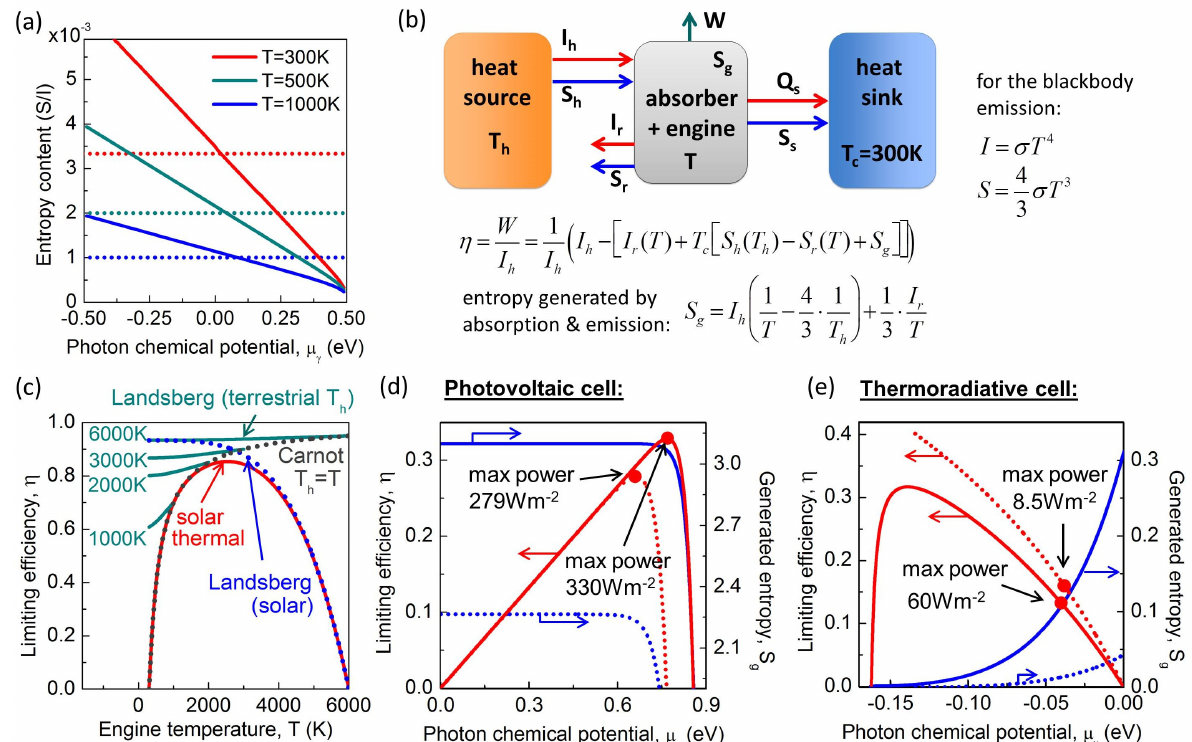
Fig. 2. Entropy of light and optical energy conversion limits. (a) The entropy content of light, defined as the ratio of the spectral entropy flux to the spectral power flux, as a function of the emitter chemical potential and temperature. The corresponding dotted lines for each temperature denote the entropy content for heat delivered at the same temperature via heat conduction (︀ S / I = T −1 )︀ . (b) Schematic of an energy-conversion device and a general expression for its conversion eflciency. (c) Eflciency limits for ideal engines when heat is delivered from the source to the engine and from the engine to the environment via conduction, that is, Carnot limit (gray dotted line) or via both radiation and conduction, that is, Landsberg limit (blue dotted line and teal solid lines). The red solid line shows the limiting eflciency of the solar thermal energy conversion that accounts for the entropy generation in the processes of photon absorption and emission. (d, e) Limiting eflciencies (red lines) and irreversible entropy generated in the converter (blue lines) of a PV cell with bandgap E g = 1.1 eV(d) and a TR cell with E g = 0.2 eV at T = 500 K (e). (d) Solid lines are for the PV cell at T = 300 K, and dotted lines are for the PV cell at T = 400 K. Red circles are the points of the maximum power generation in the PV and TR cells. (e) Solid lines are for the TR cell emitting photons of all frequencies, and the dotted lines are for a TR cell with a near-monochromatic emission at 0.2 eV and a bandwidth of 10 −5 eV.